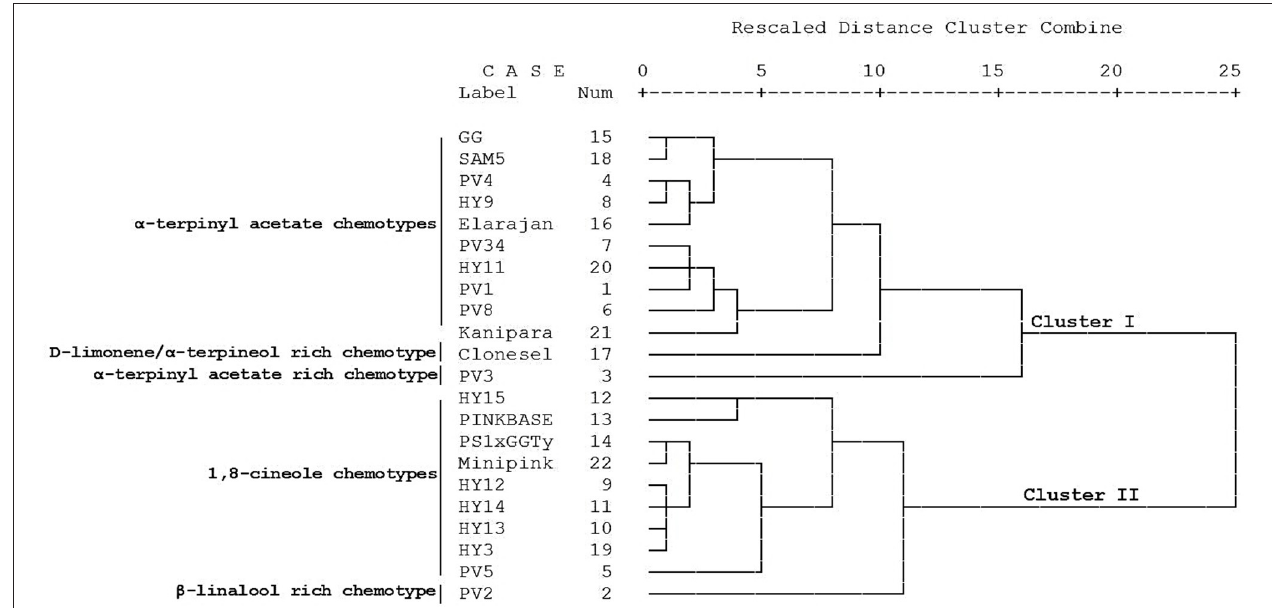
FIGURE 3 | Clustering (nearest-neighbor method using the Euclidean distance) based on oil constituents for 22 cardamom accessions.